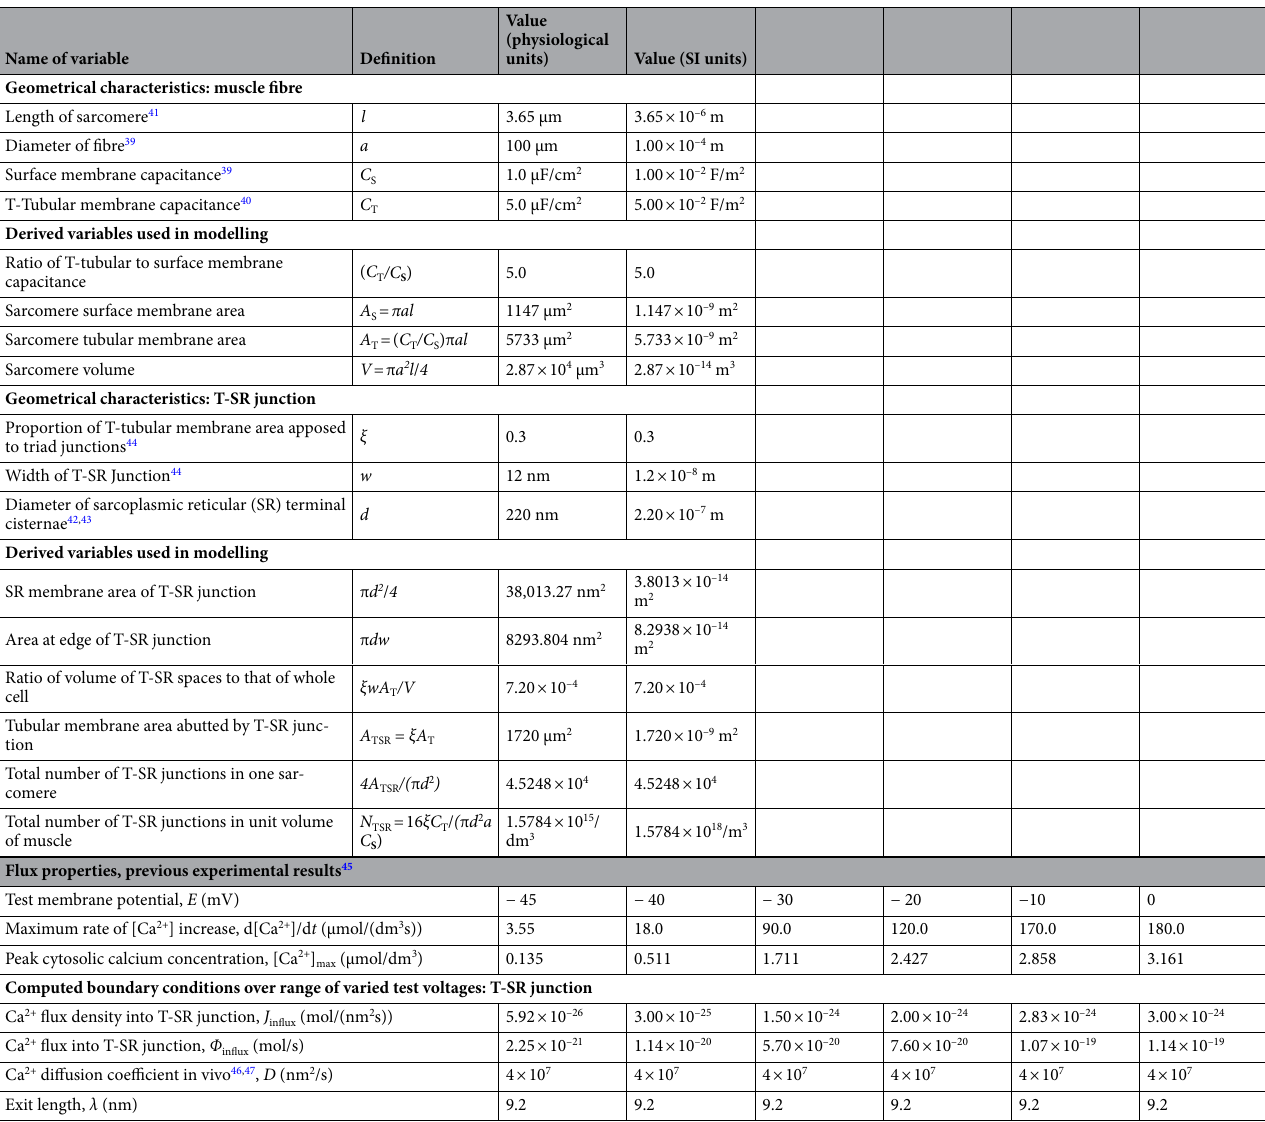
Table 1. Structural characteristics of amphibian skeletal muscle fibres and transverse tubular-sarcoplasmic reticular (T-SR)